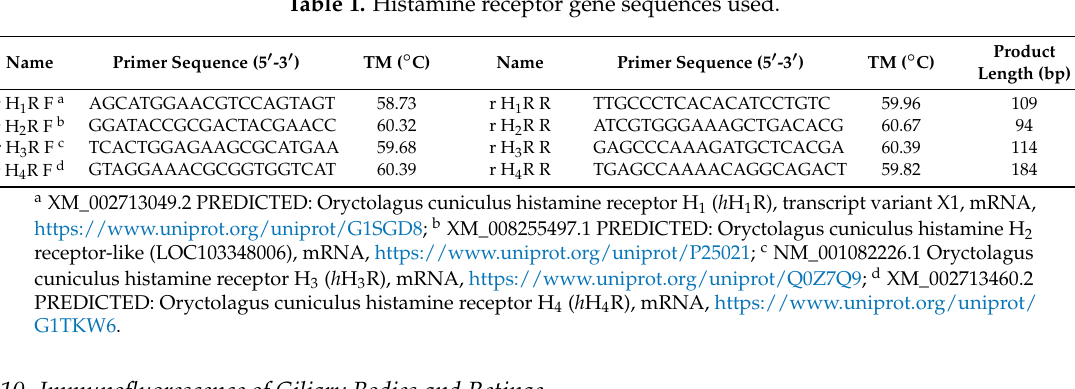
Table 1. Histamine receptor gene sequences